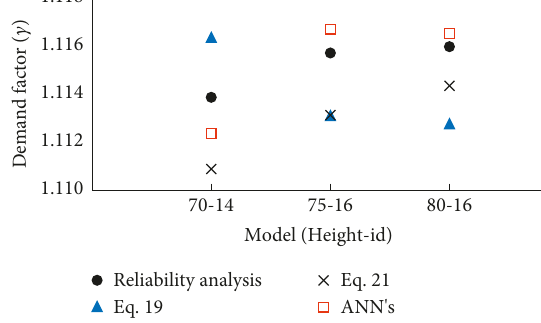
Figure 12: Comparison of results for the demand